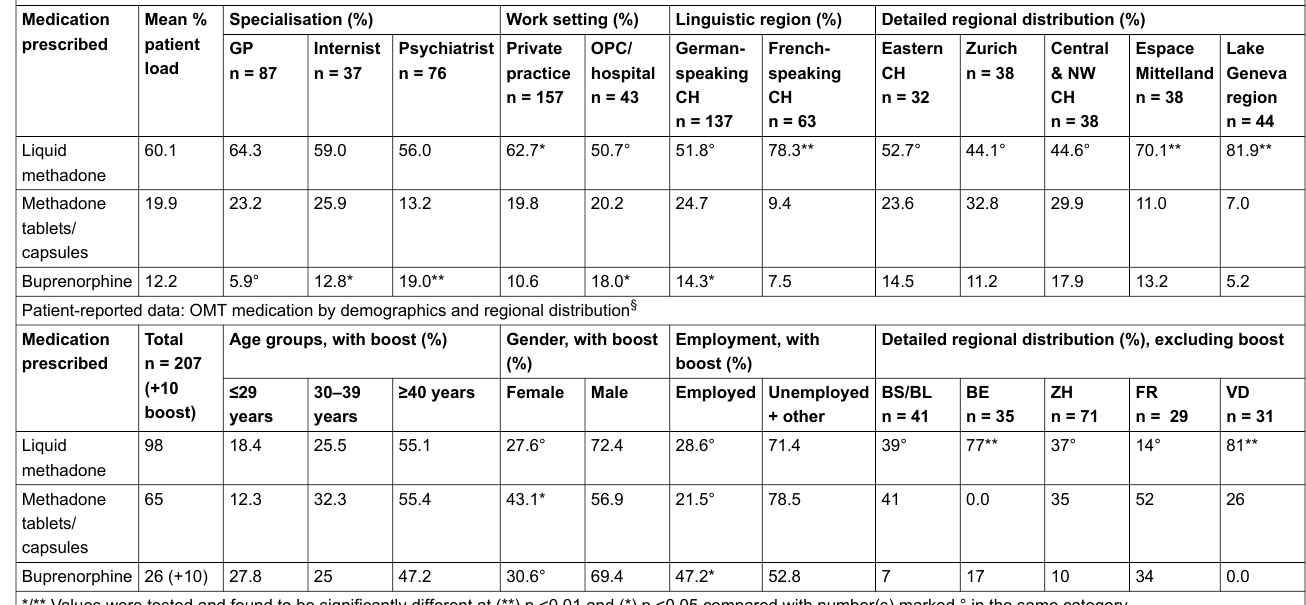
Table 2: Medication choices by demographics and by regions – physician- and patient-reported data Physician-reported data: volume of prescribed OMT medications expressed in mean percentage (%) of patient load by specialisation, work setting and linguistic and regional distribution